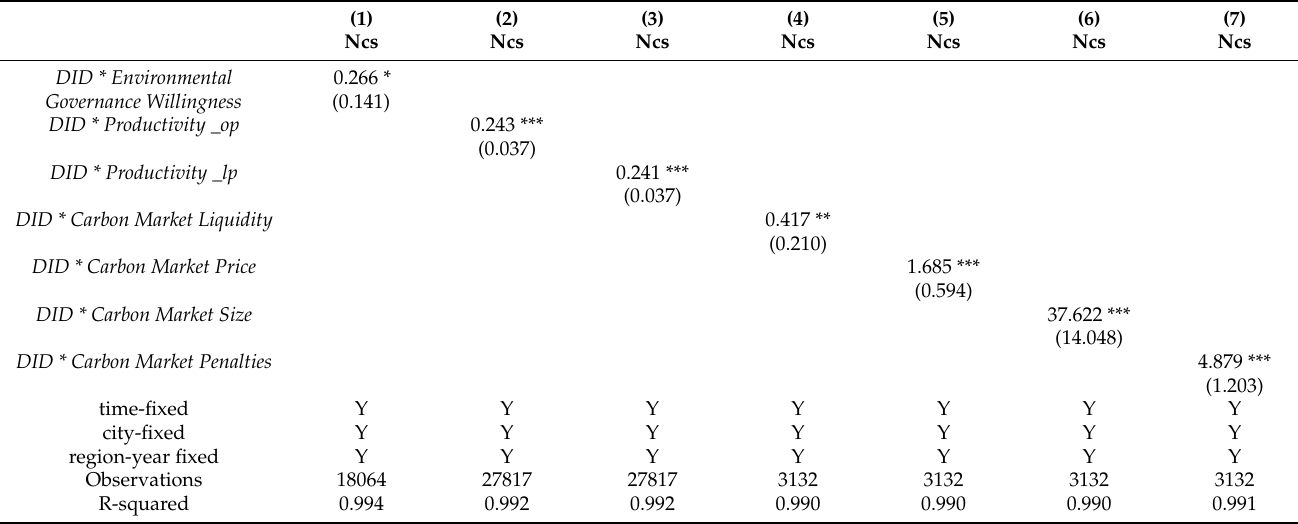
Table 8. Analysis of regulation